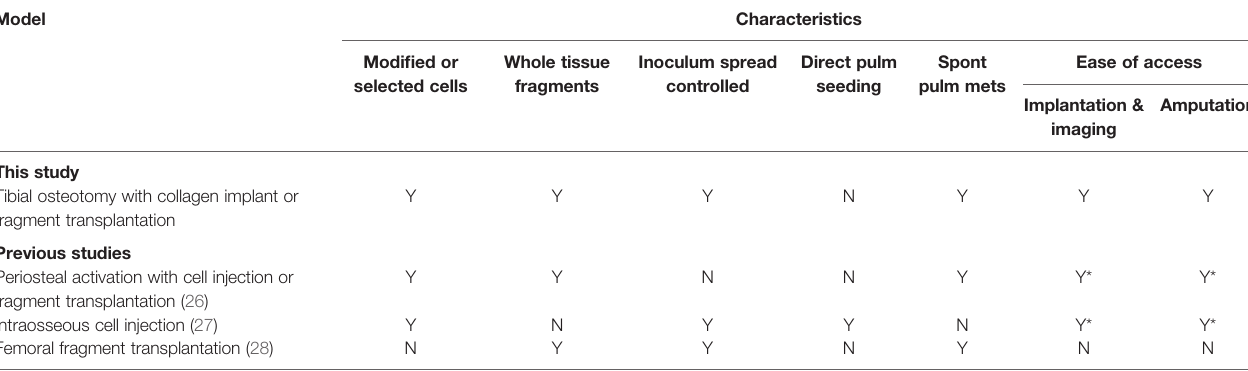
TABLE 1 | Comparison of murine orthotopic osteosarcoma